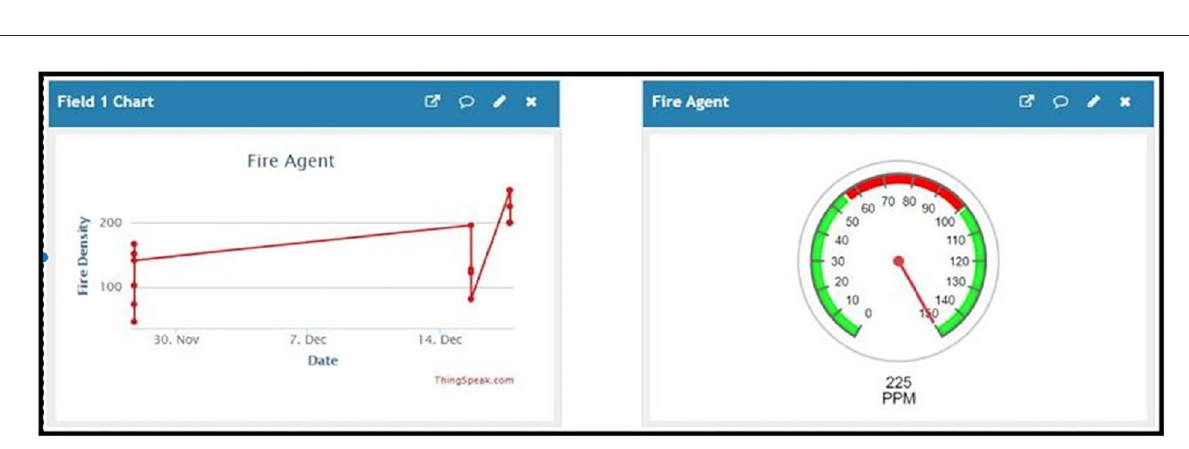
due to the external event occurrence in the system. For edge communication modeling, agents can communicate with each other only to exchange information or keep each other